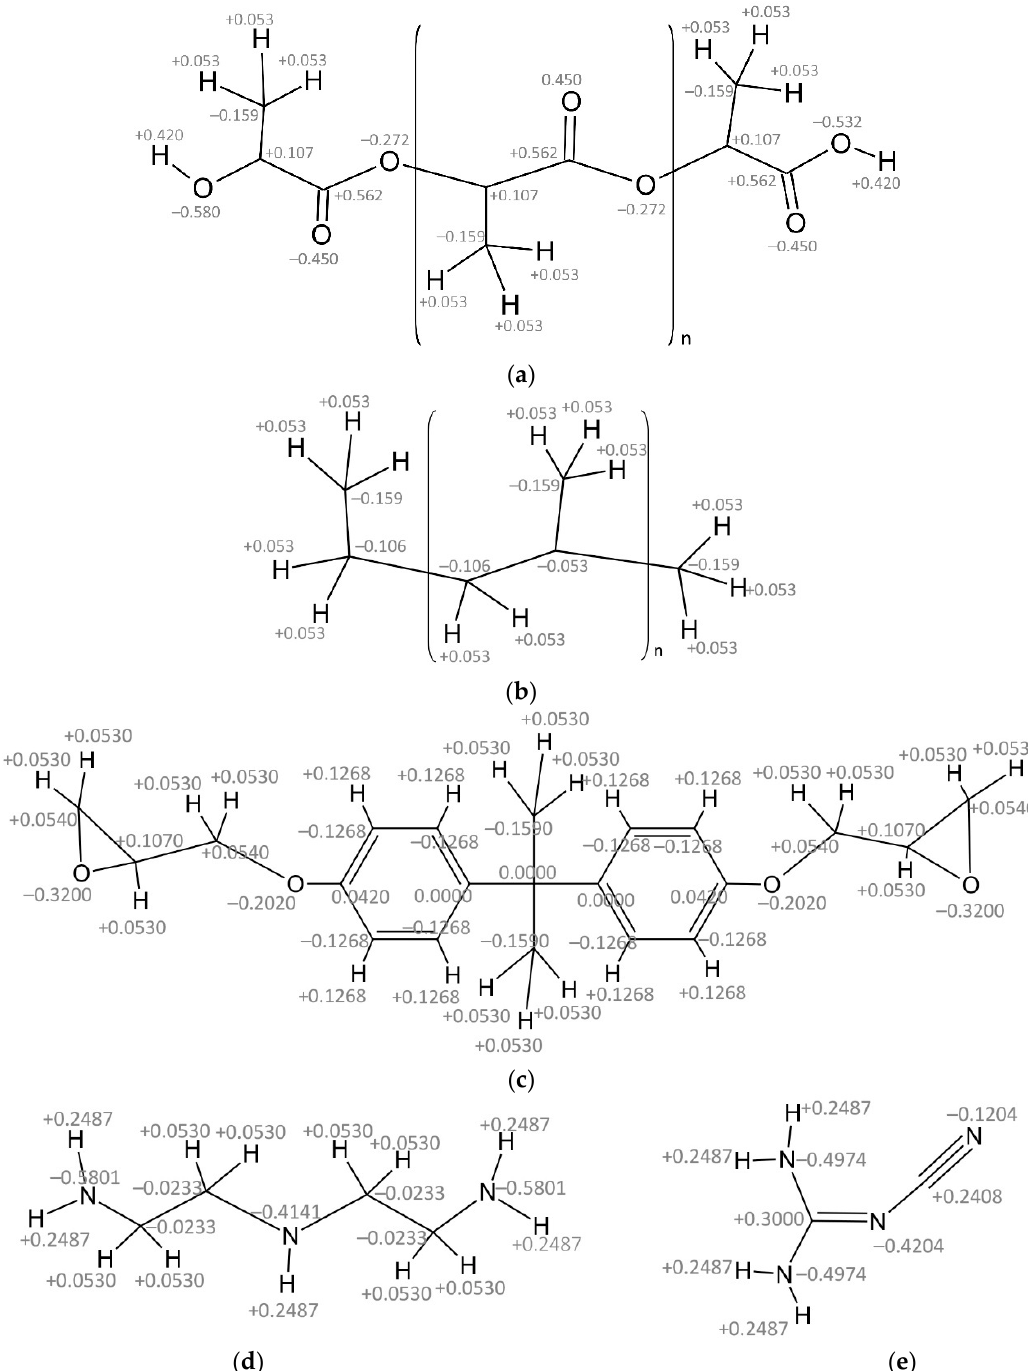
Figure 1. Structure and partial atomic charges of polymers: ( a ) polylactic acid (PLA); ( b ) polypropylene (PP); epoxy resin molecules: ( c ) DGEBA, ( d ) DETA and ( e ) DICY.